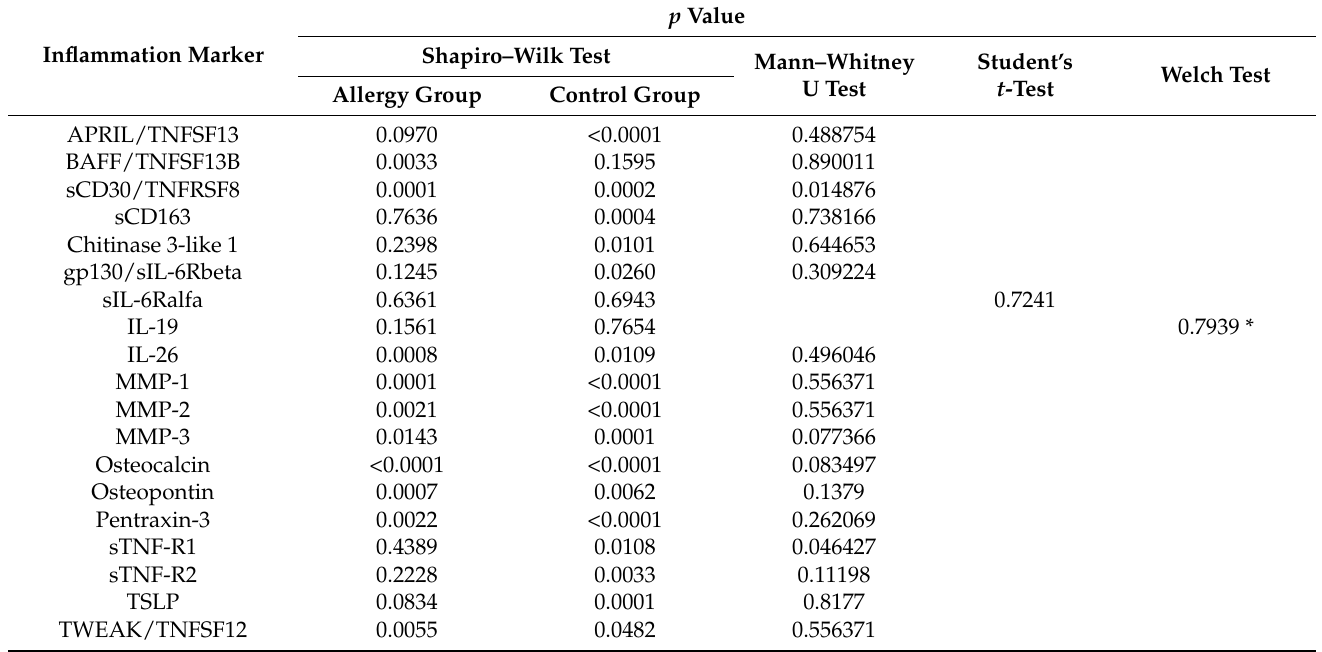
Table 3. Results of univariate statistical analysis of serum inflammation markers in patients with allergy and the control group. p values indicates statistical significance.